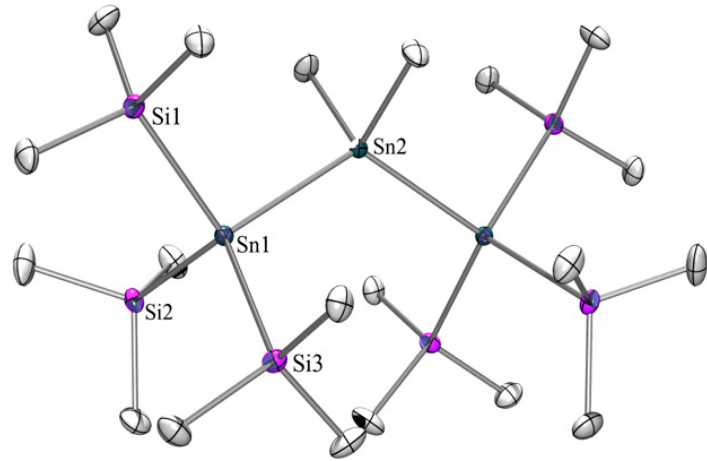
Figure 5. Molecular structure of 8 (thermal ellipsoid plot drawn at the 30% probability level). All hydrogen atoms are not shown for clarity (bond lengths in Å, angles in °). Sn(1)–Si(3) 2.5658(7), Sn(1)–Si(1) 2.5728(8), Sn(1)–Si(2) 2.5758(8), Sn(1)–Sn(2) 2.7871(6), Sn(2)–C(10) 2.179(3), Sn(2)–Sn(1A)